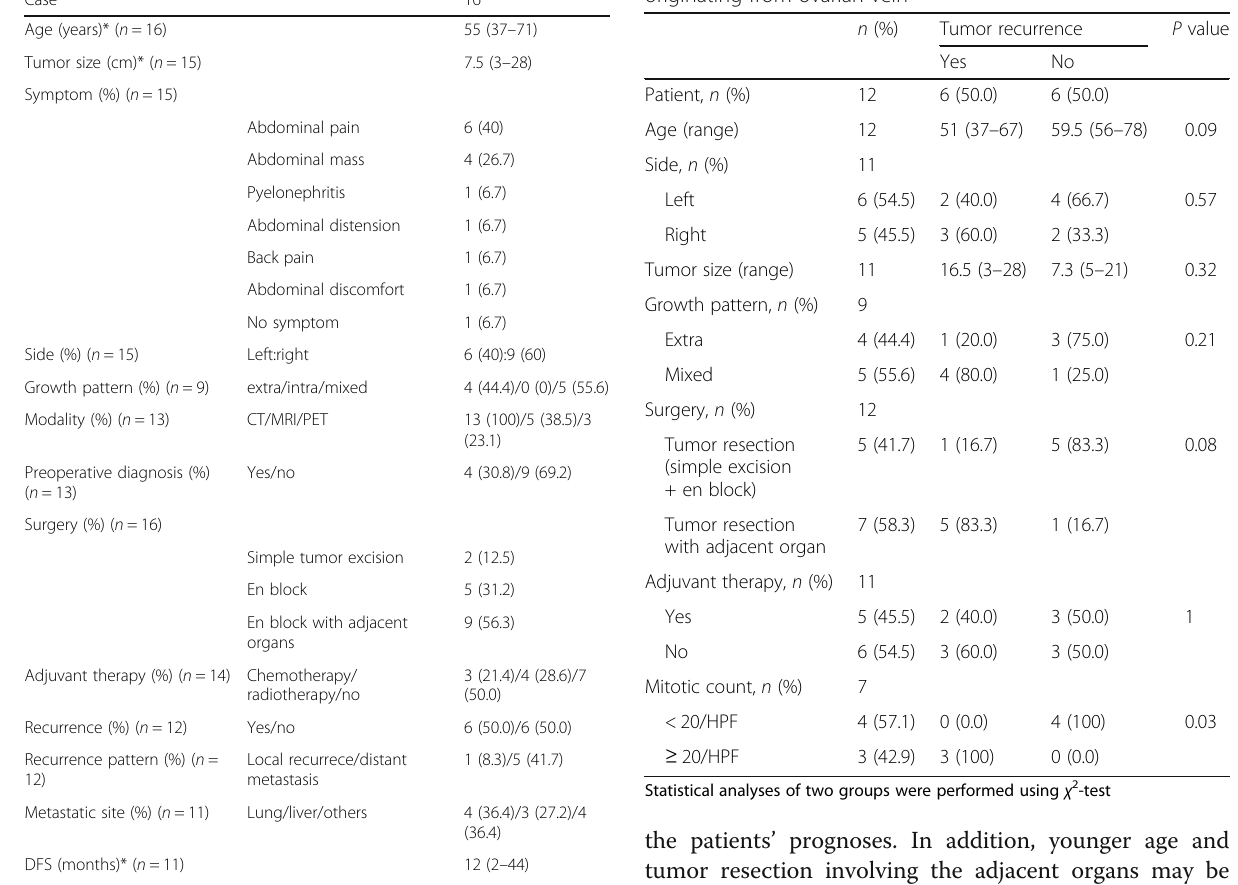
Table 2 Correlation between tumor recurrence and clinicopathological factors in patients with leiomyosarcoma originating from ovarian